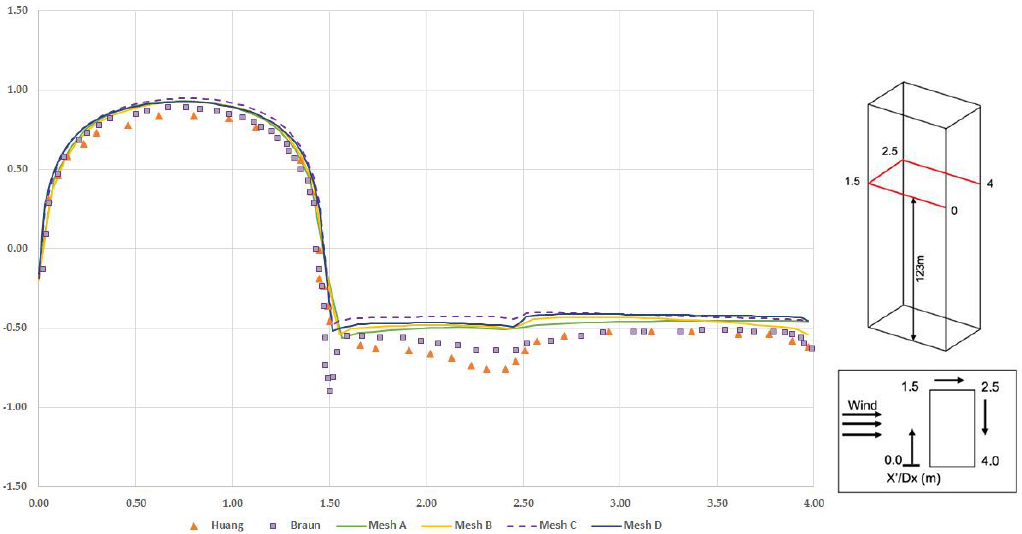
Figure 6. Mesh sensitivity results in terms of pressure coefficient around the windward, side, and leeward surfaces of the benchmark building model at the height of 2/3 h, 123 m above ground using various meshing configurations indicated in Table 4 and compared with the study by Huang et al. [53] and Braun and Awruch [55].